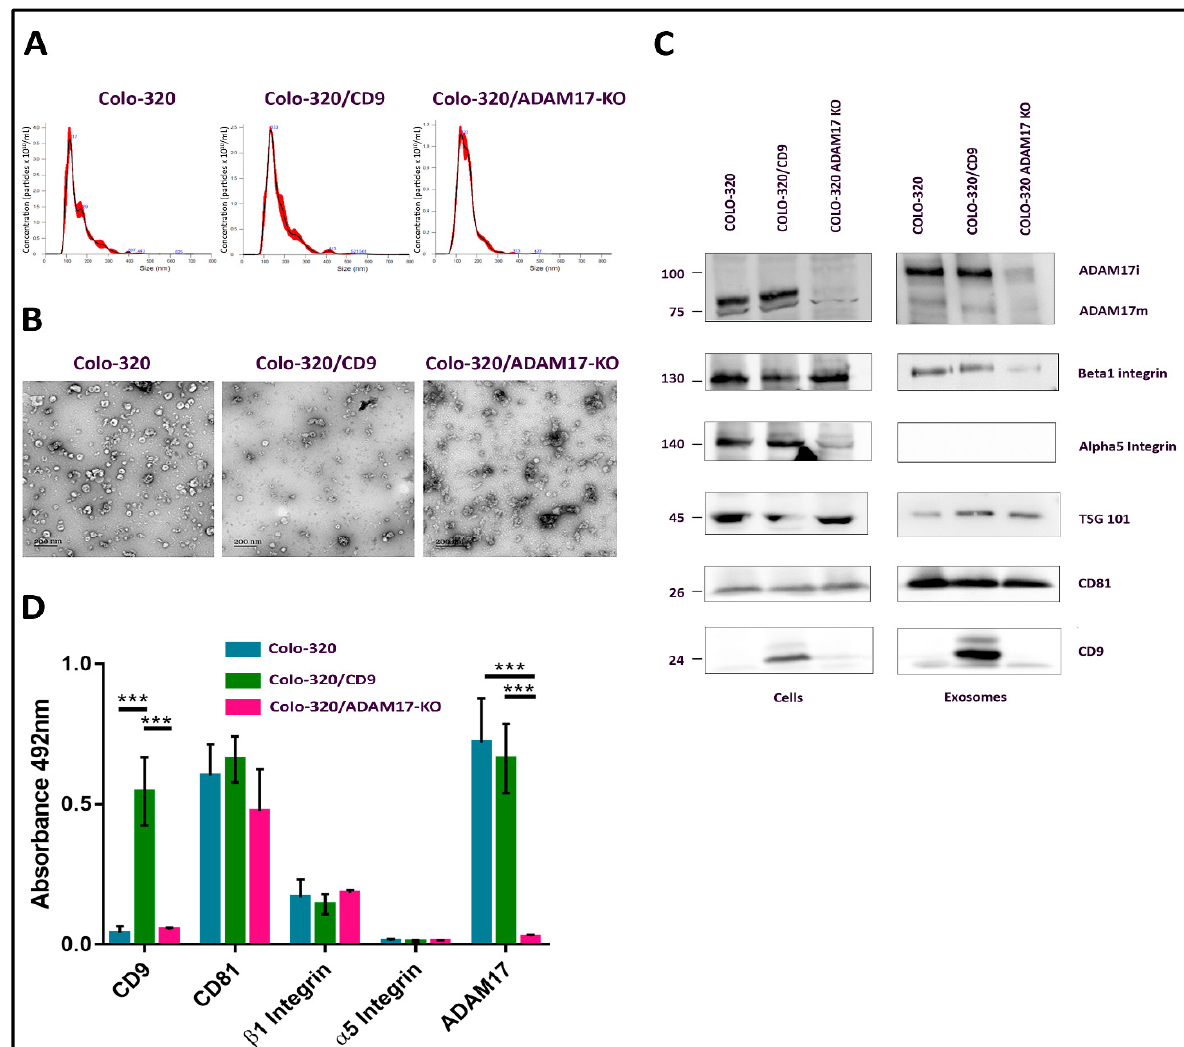
Figure 2. Characterization of exosomes produced by Colo-320 cells. ( A ) NTA analysis of the number and size of particles (exosomes) produced by Colo-320, Colo-320/CD9 and Colo-320/ADAM17-KO. ( B ) Transmission electron microscopy of exosomes produced by Colo-320, Colo-320/CD9 and Colo-320/ADAM17-KO. Scale bars= 200 nm. ( C ) Western blot showing the expression of ADAM17, CD9, CD81, TSG101, integrin β 1 and integrin α 5 in Colo-320, Colo-320/CD9 and Colo-320/ADAM17-KO cells and in their respective exosomes. Blots are representative of three different experiments. (ADAM17i: the immature form of the enzyme that contains the prodomain; ADAM17m: the mature form without the prodomain). ( D ) Detection of CD9, CD81, integrin β , integrin α 5 and ADAM17 by enzyme-linked immunosorbent assay (ELISA) on immobilized exosomes produced by Colo-320, Colo-320/CD9 and Colo-320/ADAM17-KO cells. Data correspond to the mean ± SEM of three different experiments, each performed in duplicates. Statistical analysis performed was two-way ANOVA *** p < 0.001.